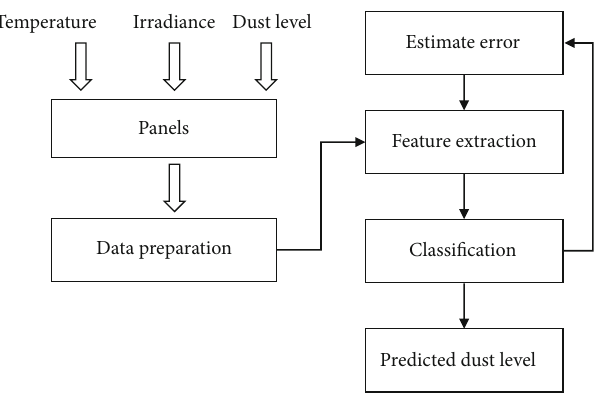
Figure 2: Proposed algorithm.